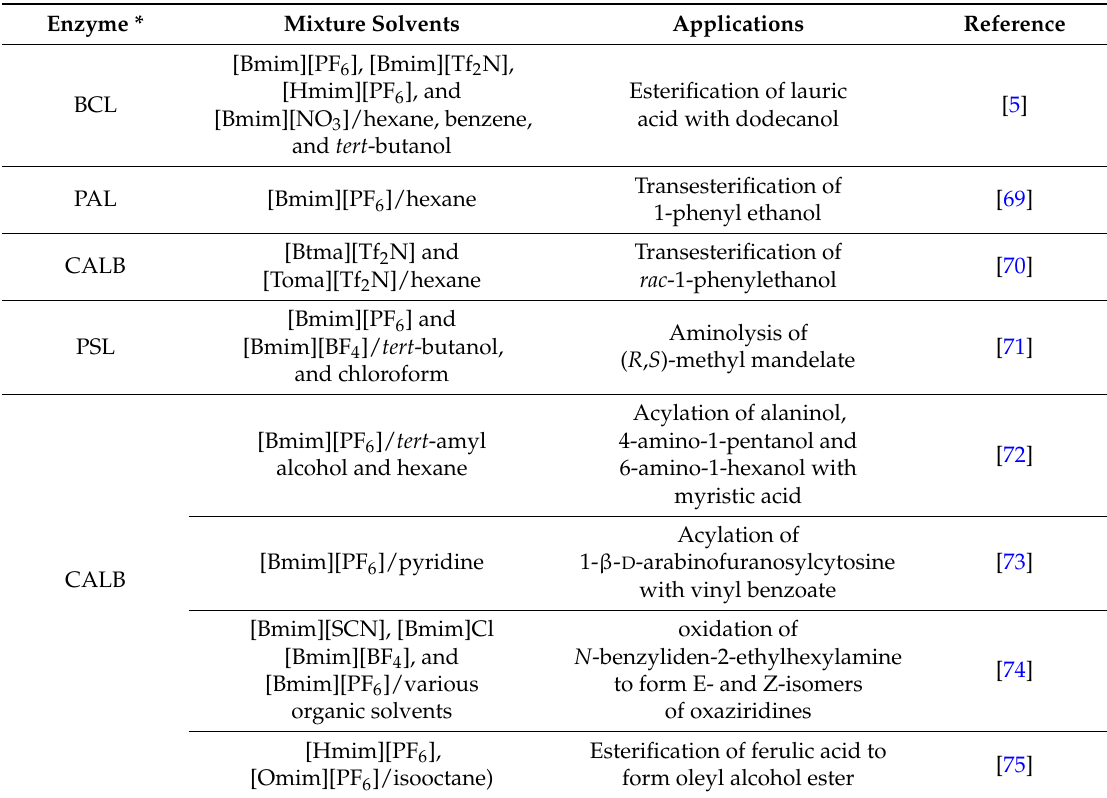
Table 2. Activity of enzyme in mixture solvents of organic solvent and ionic